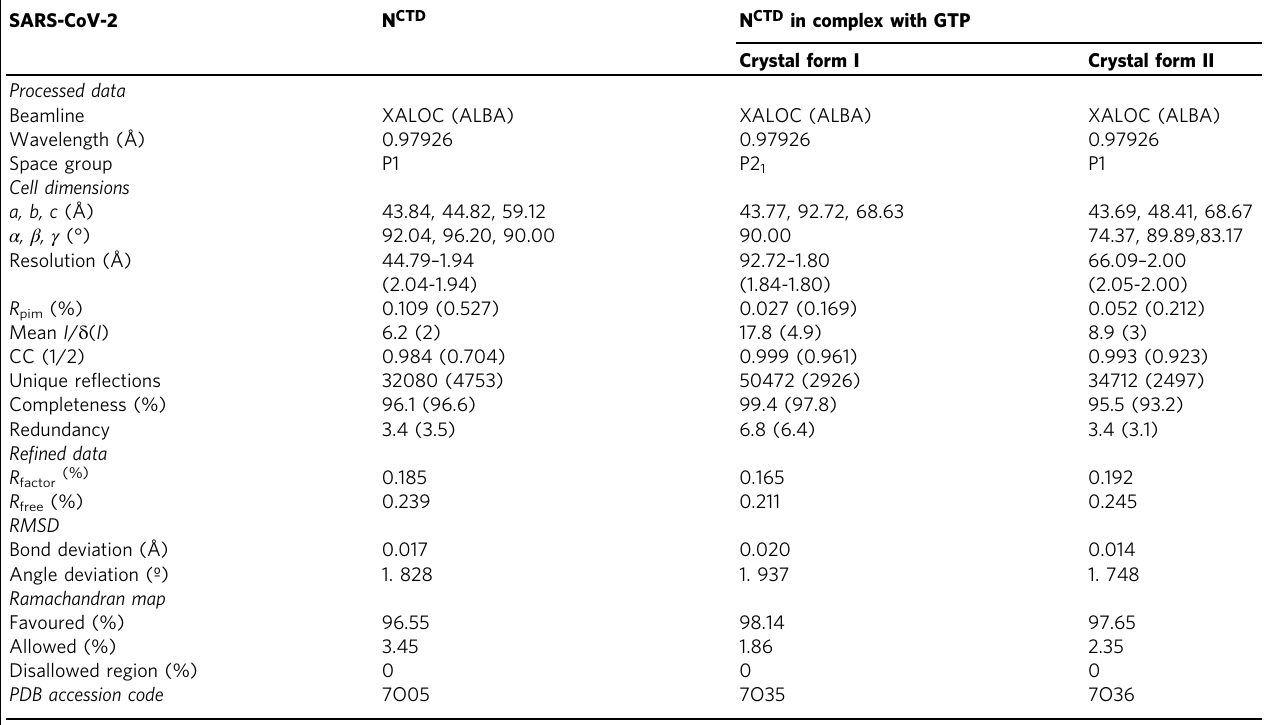
Table 1 Data collection and crystallographic